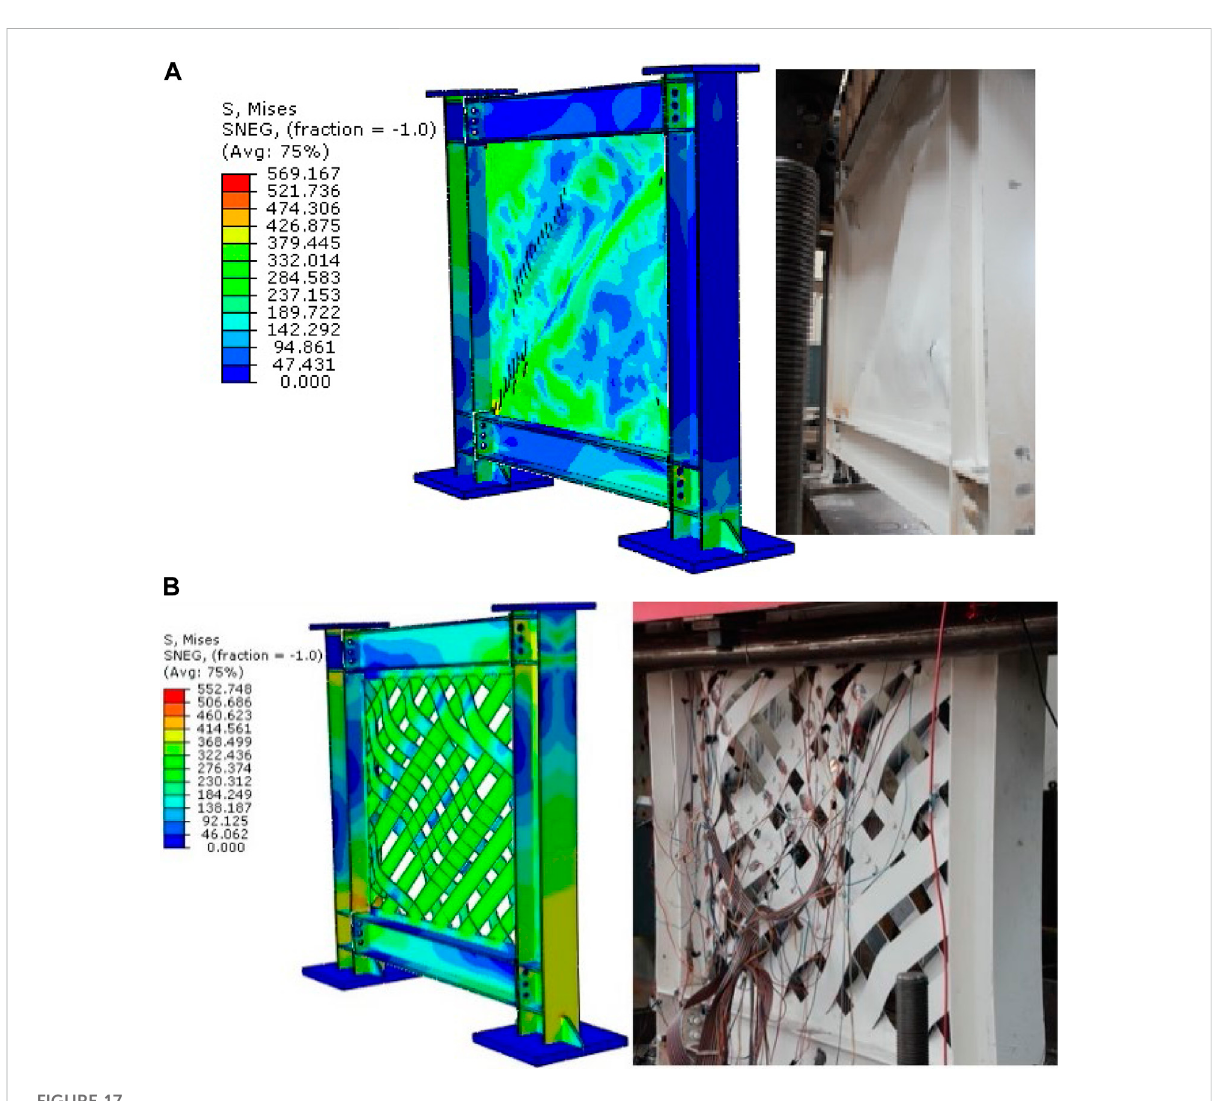
FIGURE 17 Comparison of failure mode: (A) USPSW, and (B)